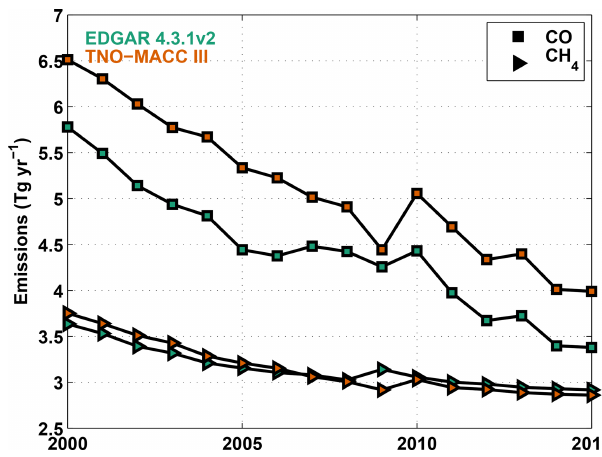
Figure 3. This figure shows the summed EDGAR (green) and TNO-MACC_III (orange) emissions within the study area for CO (squares) and CH 4 (triangles). The study area is defined in Fig. 1. All emissions are shown in units of Tgyr − 1 . Extrapolation begins after 2010 for EDGAR and 2011 for